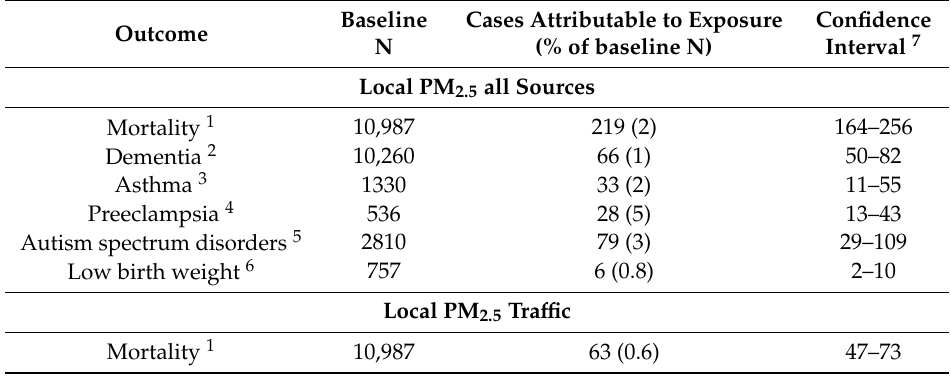
Table 3. Health impacts from various PM 2.5 sources using modelled concentrations for 2011 applied to Scania’s 2016